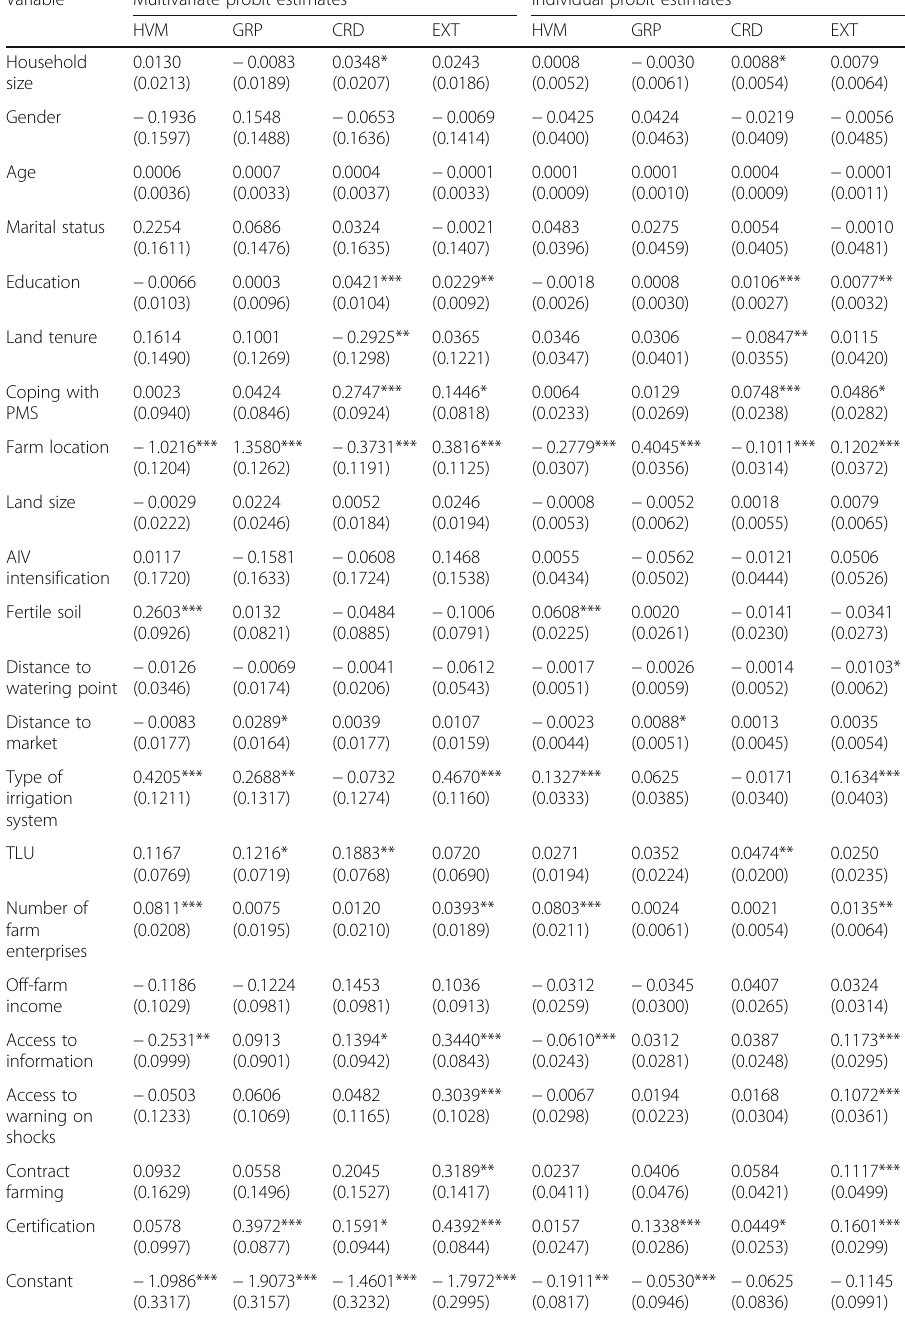
Table 3 Parameter estimates from multivariate probit and individual probit models for estimating determinants of pillars of competitiveness in HVMC